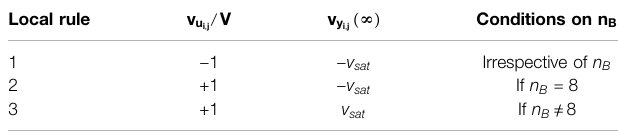
TABLE 1 | Local rule triplet, which, irrespective of its location within the cellular array, a processing element C ( i , j ) is requested to obey, for the extraction of edges from an input binary image, preliminarily discretized into a M × N matrix of pixels ( i ∈ { 1 , ... , M } , j ∈ { 1 , ... , N }